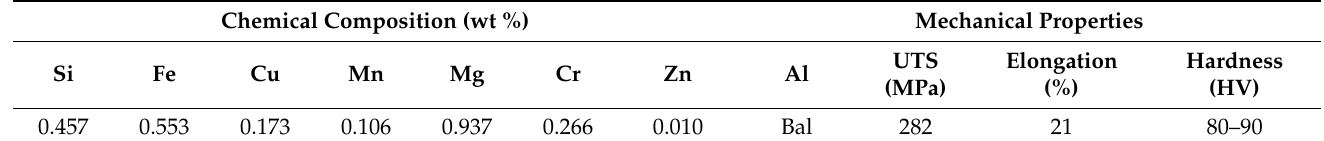
Table 1. The chemical composition and mechanical properties of base metal.